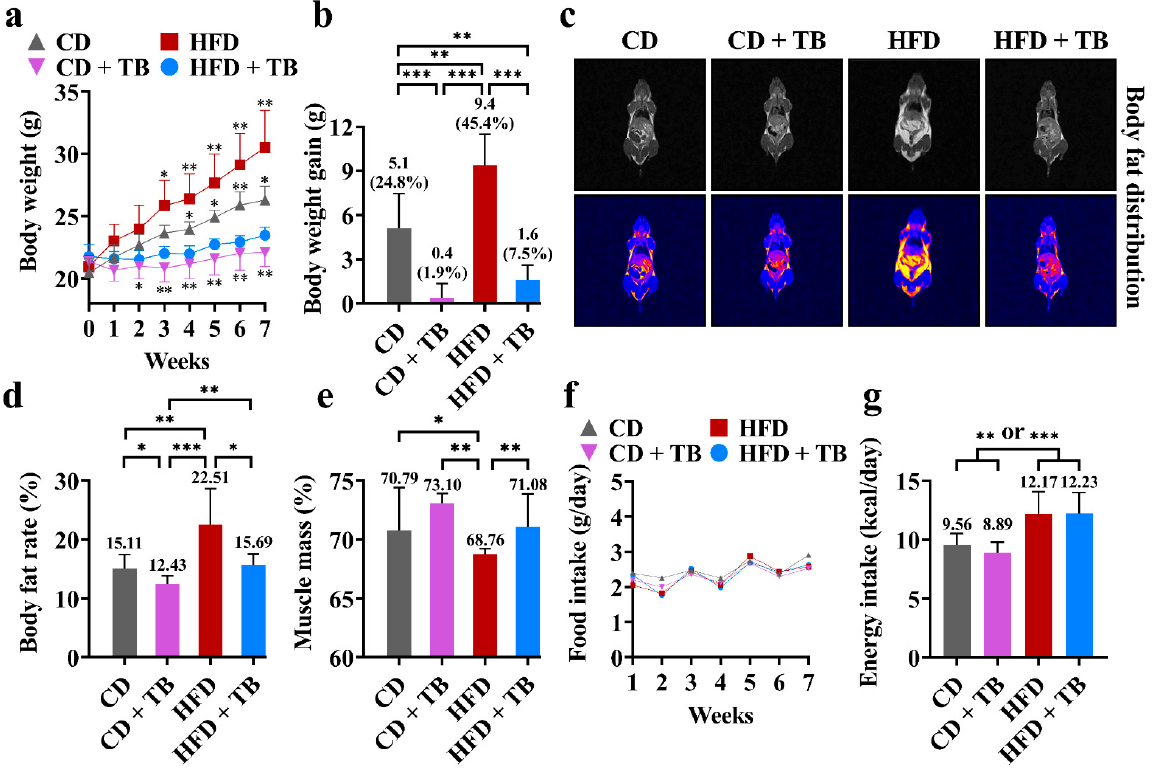
Figure 2. The effects of TB on obesity. ( a ) The trend of body weight change. ( b ) Body weight gain at the end of the experiment. ( c ) The images of body fat distribution with or without pseudo color by nuclear magnetic resonance scan (the bright light parts are adipose tissue). ( d ) The body fat rate at the end of the experiment. ( e ) The muscle mass rate at the end of the experiment. ( f ) Average food intake per mouse. ( g ) Average energy intake per mouse. * p -value < 0.05, ** p -value < 0.01, *** p -value < 0.001. Abbreviation: CD, control diet; HFD, high-fat diet; TB, theabrownin.